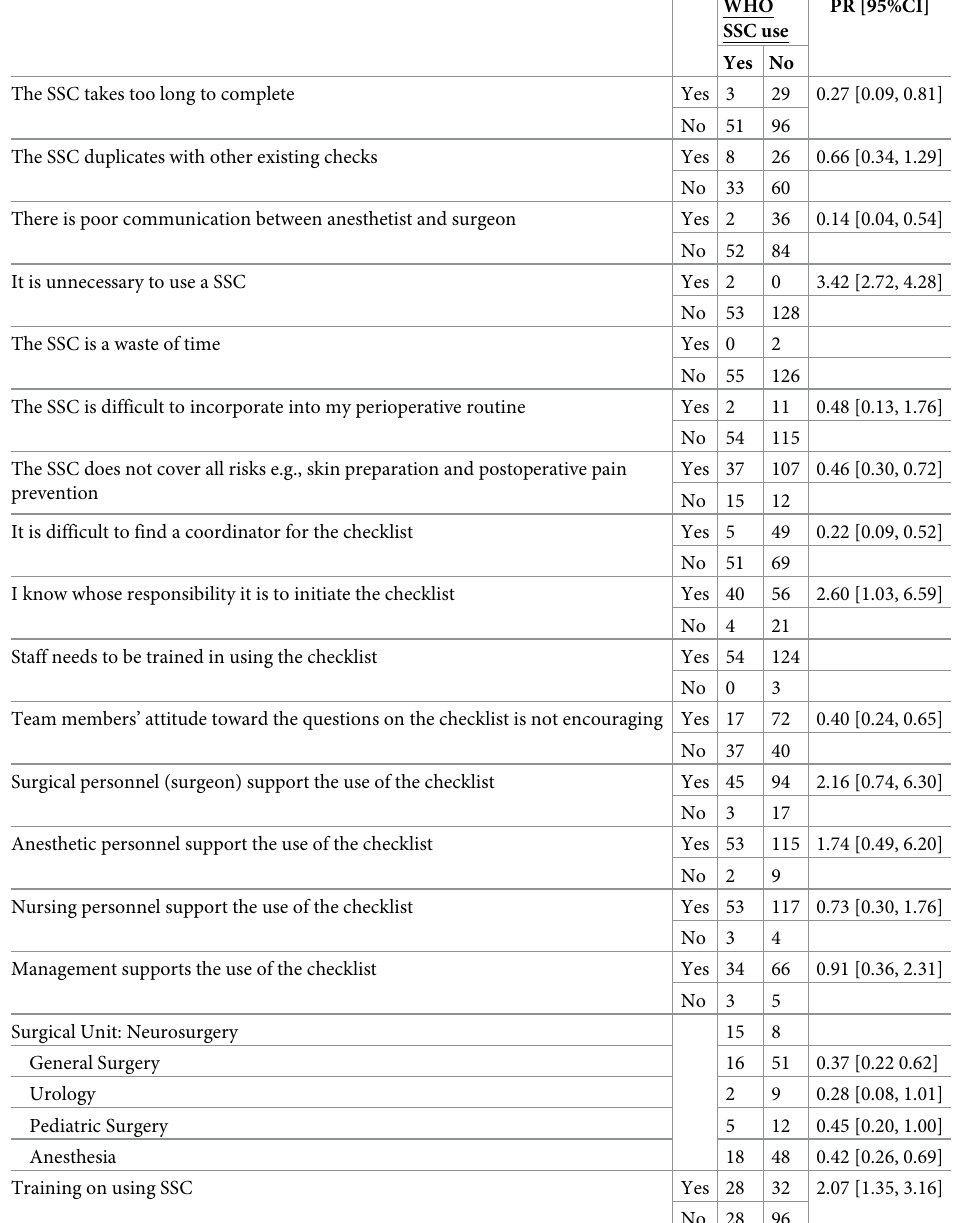
Table 4. Association between surgical provider’s beliefs or barriers and utilization of the WHO Surgical Safety Checklist. The SSC takes too long to complete Yes 3 29 0.27 [0.09, 0.81]